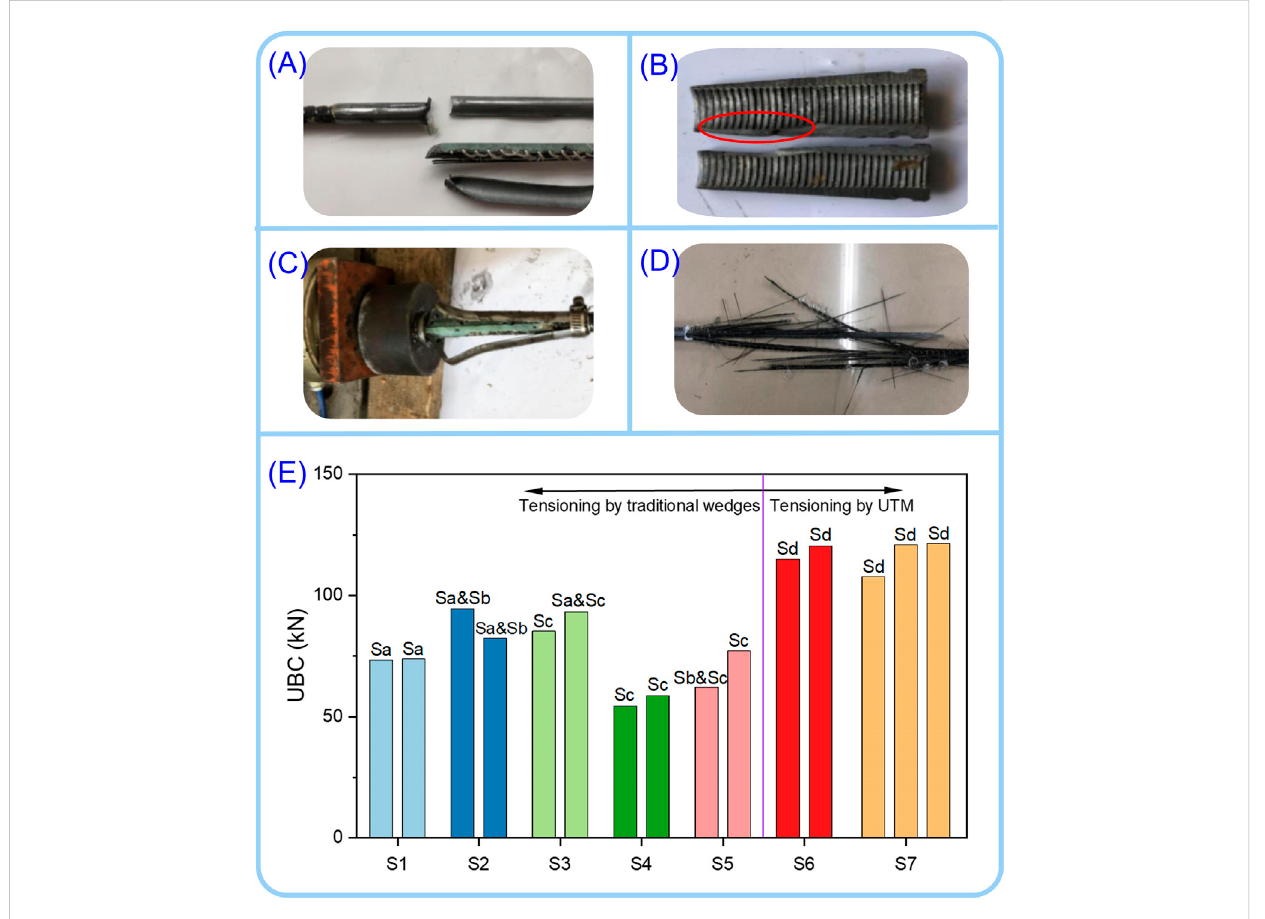
FIGURE 7 FailuremodesandUBC testresults oftheSBAS: (A) TransversefractureoftheBFRP bar(Sa), (B) localfractureofthewedge (Sb), (C) deformationand debonding of the steel sleeve (Sc), (D) BFRP bar bursting (Sd), (E) UBC test results of the